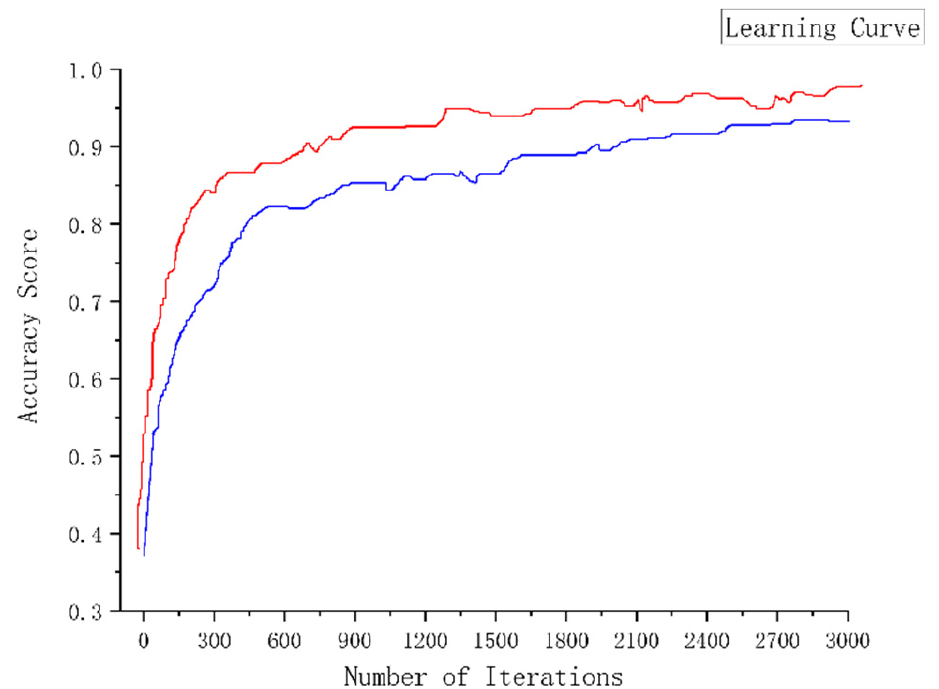
Figure 5. Learning Curve. The horizontal axis of the figure in the figure represents the number of iterations. The vertical axis represents the training accuracy. The blue line is the training curve without patch optimization and gradient balance, and the red line is the training result after the module is introduced. It can be clearly seen that the addition of modules makes the model learn faster and better, and the optimization node ushered in at an earlier time.